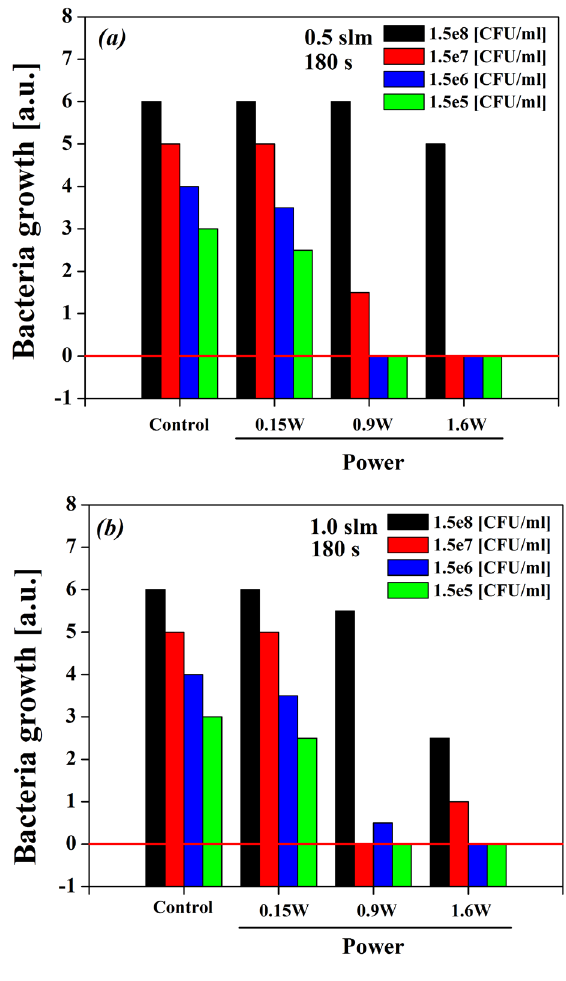
Figure 6: Sterilization of Pseudomonas aeruginosa ATCC 27853. The samples contained four different concentrations of bacteria. The untreated control values are 6(1.5×10 8 CFU mL -1 ), 5(1.5×10 7 CFU mL -1 ), 4(1.5×10 6 CFU mL -1 ) and 3(1.5×10 5 CFU mL -1 ). Treatment time was 180 s. (a) He flow 0.5 sLm; (b) He flow 1 sLm. The red line represents complete sterilization of the